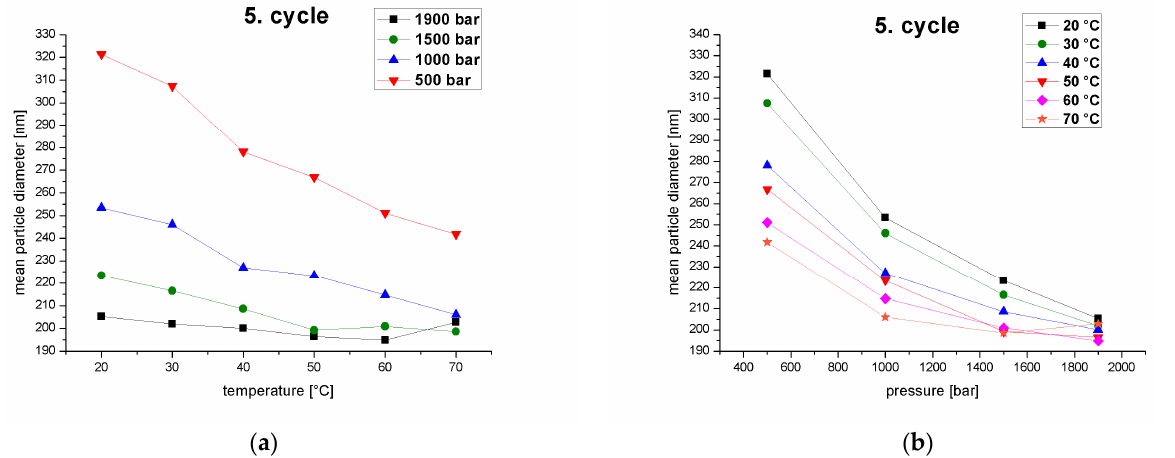
Figure 7. MPD of the fifth homogenization cycle as a function of ( a ) temperature at different operating pressures (500–1900 bar) and ( b ) operating pressure at different emulsion temperatures at the inlet of the homogenizer (20–70 °C).